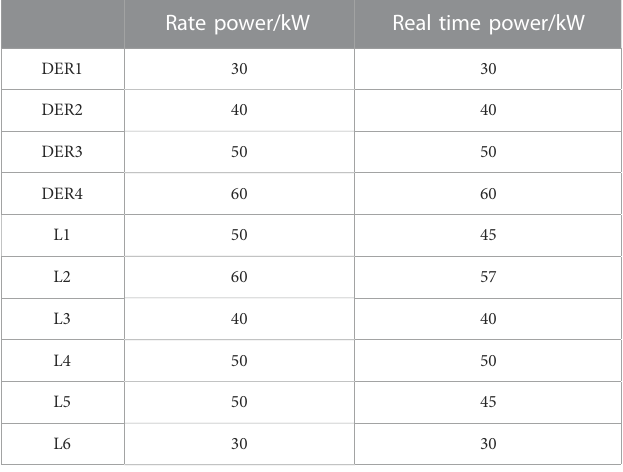
TABLE 2 Data information of DGs and loads.